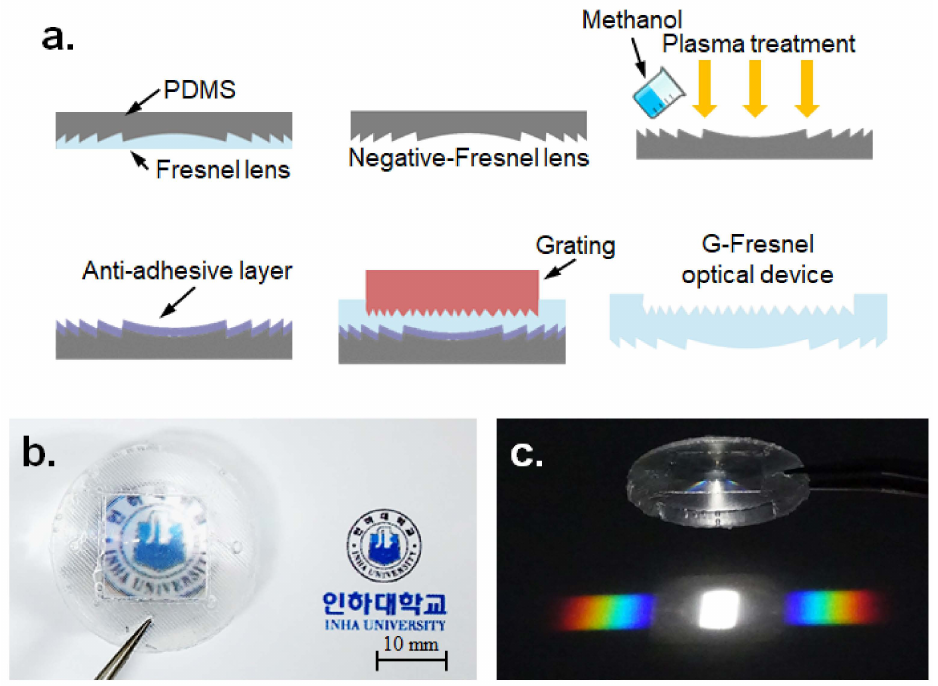
Figure 2. The G-Fresnel optical device. ( a ) Schematic of the manufacturing process, ( b ) and ( c ) Photograph and spectrum of a white light emitting diode (LED). PDMS =